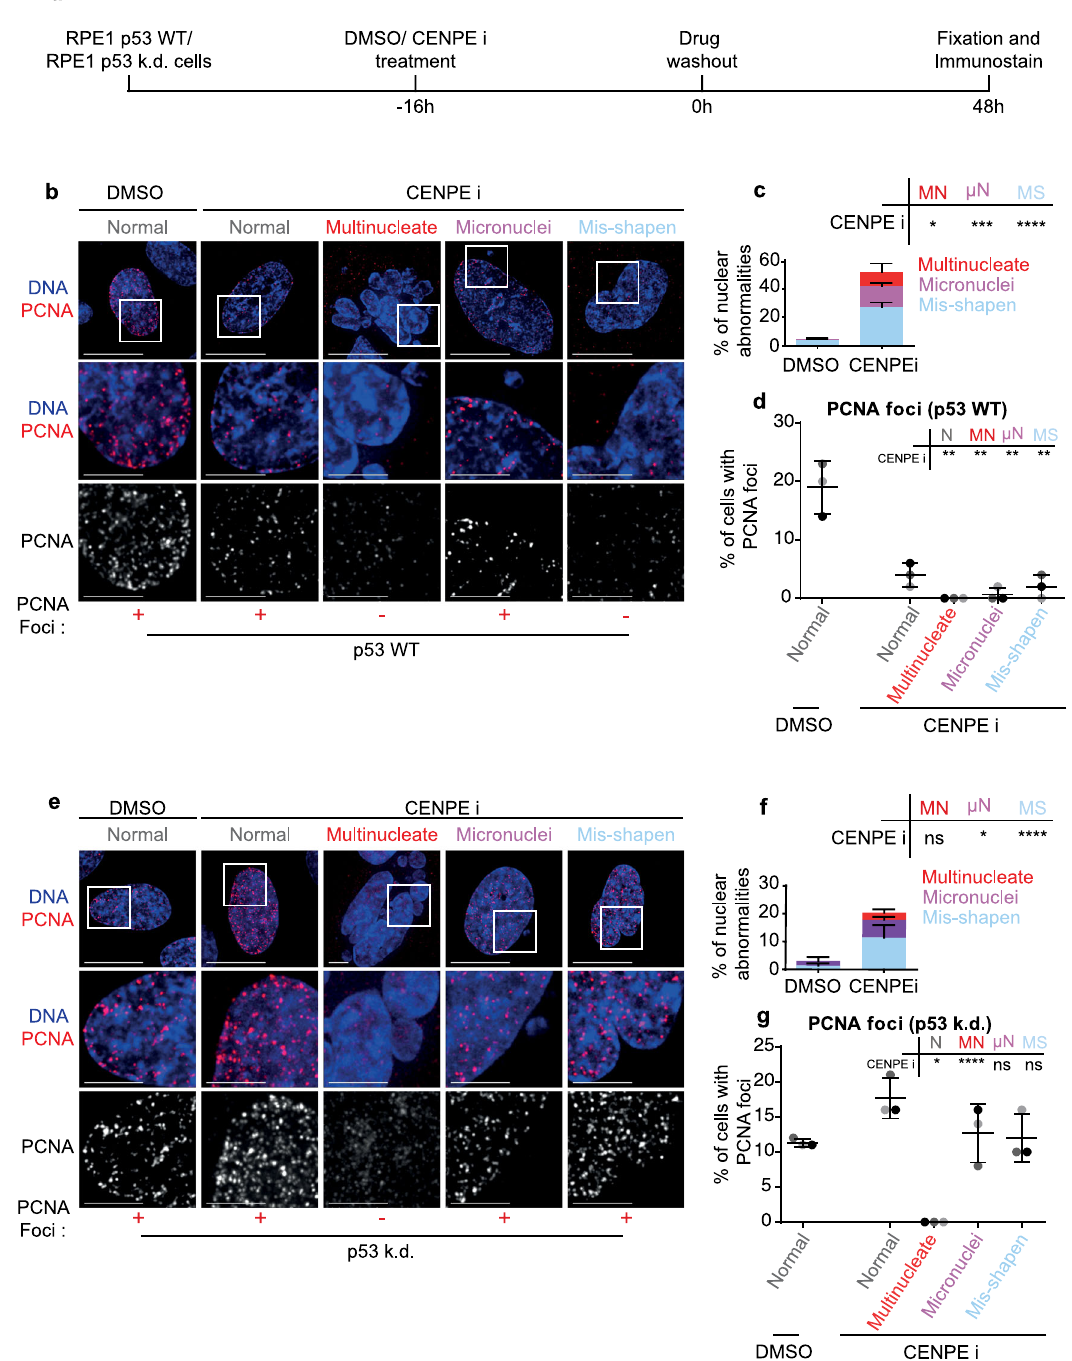
Fig. 1 Unlike other nuclear atypia, multinucleation induces a G1 arrest, independent of p53. a Experimental regime; RPE1 p53 wild type (WT) or RPE1 p53 knockdown (k.d.) were treated with DMSO or CENPE inhibitor for 16 h, then washed out. 48 h later cells were assessed for PCNA and nuclear status. Images of RPE1 p53 WT ( b ) or p53 k.d ( e ) cells treated as in a. Scale 15 μ m, insets 5 μ m. ± refers to PCNA foci positive or negative nuclei displayed. In Fig. 1b, a micronuclei bearing cell displaying PCNA-foci has been chosen, although the majority lack PCNA-foci. Quanti fi cation of nuclear morphology changes after treatment of RPE1 p53 WT ( c ) or p53 k.d ( f ) cells with DMSO or CENPE inhibitor, as in ( a ). Nuclei were classi fi ed as either Mis-shapen (MS), Micronucleated ( μ N) or Multinucleated (MN). N = 600 cells, 3 independent experimental repeats shown as shades of grey. Statistical analysis was using a two-way ANOVA with multiple comparisons and a con fi dence interval of 95%. d , g Quanti fi cation of the percentage of PCNA-foci positive cells, within each nuclear morphology bin, following DMSO or CENPE inhibitor treatment, of RPE1 p53 WT ( c ) or p53 k.d ( f ) cells. N > 150, 3 independent experimental repeats shown as shades of grey. Statistical analysis was using multiple unpaired t tests, comparing each morphology after CENPE inhibition to normal nuclei after DMSO